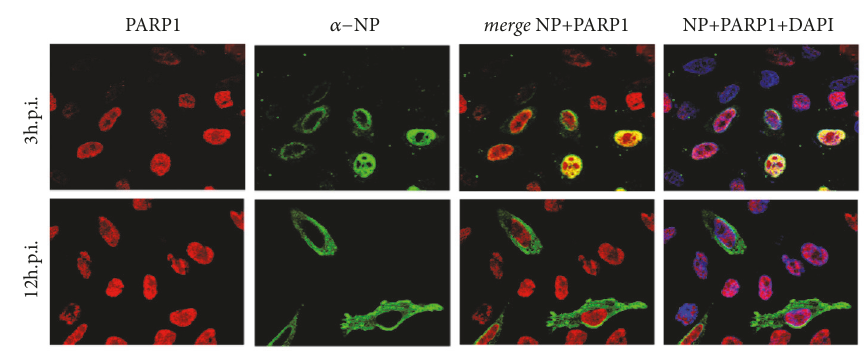
Figure 5: PARP1 remains in the nucleus in cells infected with influenza A virus. Human HeLa cells were infected with low-path, avian-derived influenza virus strain A/Viet Nam/1203/04 (H5N1) HALo (MOI = 0.5). Infected cell cultures were fixed for immunofluorescence 3h.p.i. and 12h.p.i. with anti-PARP ( red ) and anti-NP ( green ), and DAPI chromatin counterstaining indicating cell nuclei ( blue ).